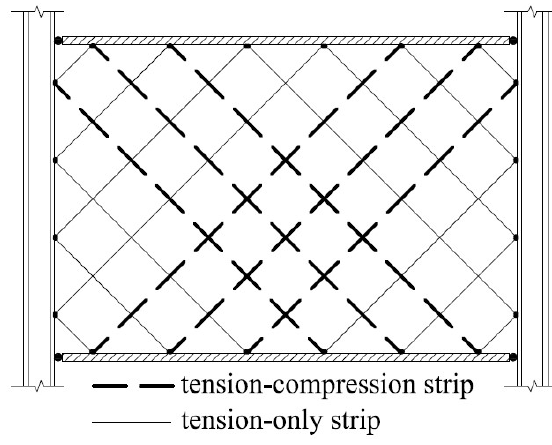
Figure 1. Simplified analysis model of SPSW.